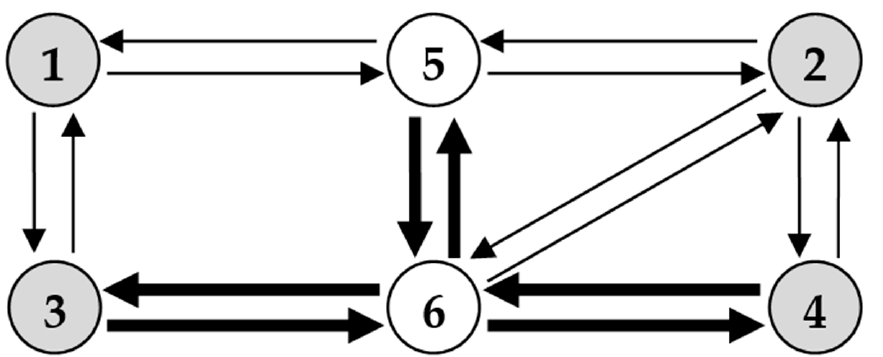
Figure 2. Small Figure 2. Small network. Table 1. Features of the small network.